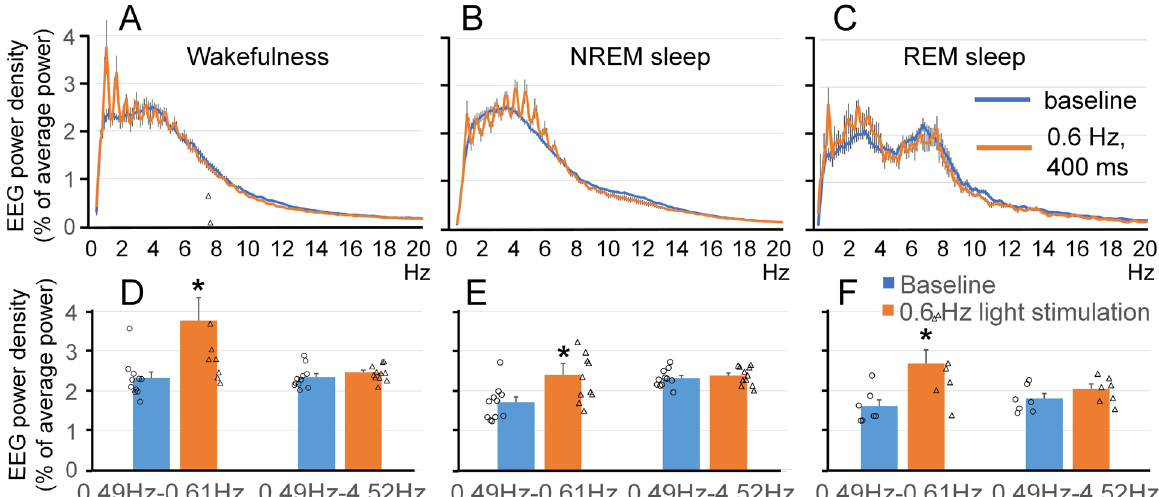
Figure 2. Effect of visual stimulation with 400-ms 620-nm light pulses at 0.6 Hz on EEG power spectrum. A peak at the fundamental frequency of 0.6 Hz and multiple harmonics as an integer of this frequency were present during visual stimulation. A similar response to visual stimulation was observed on the spectrogram during wakefulness ( A ), NREM sleep ( B ) and REM sleep ( C ). EEG power in the stimulation frequency range (0.49–0.61 Hz) was higher during the light stimulation than baseline in all three states, wakefulness ( D ), NREM sleep ( E ) and REM sleep ( F ), whereas EEG power in the delta frequency range (0.49–4.52 Hz) did not change significantly. * p < 0.05.